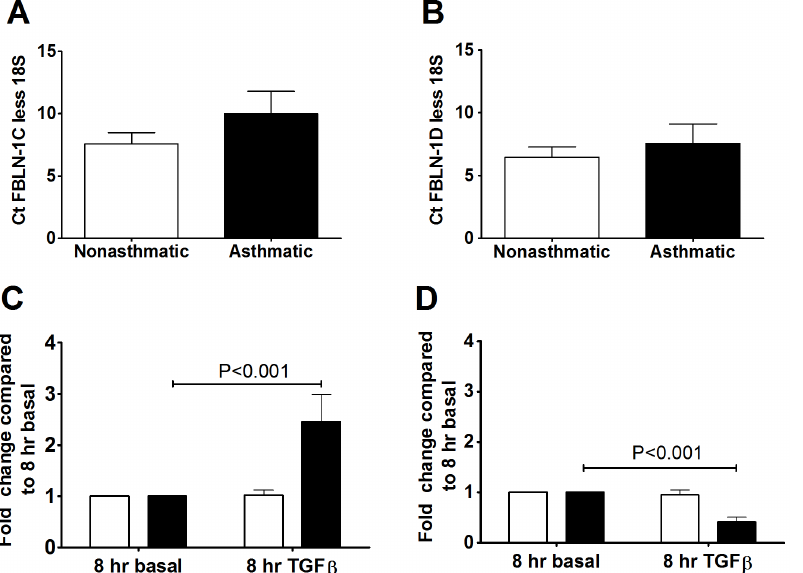
Figure 2. TGF b induced FBLN-1C mRNA in asthmatic ASM cells. Basal expression of FBLN-1C (A) and FBLN-1D (B) mRNA (expressed as cycle threshold difference between FBLN-1C or D and 18s rRNA) from ASM cells collected from non-asthmatic (white bars n=12) or asthmatic (black bars, n=8) volunteers, or expression following treatment for 8 h with TGF b of FBLN-1C (C) and FBLN-1D (D) (data were normalized to 18s rRNA and are expressed relative to BSA at 8 h). Data are expressed as mean 6 SEM.